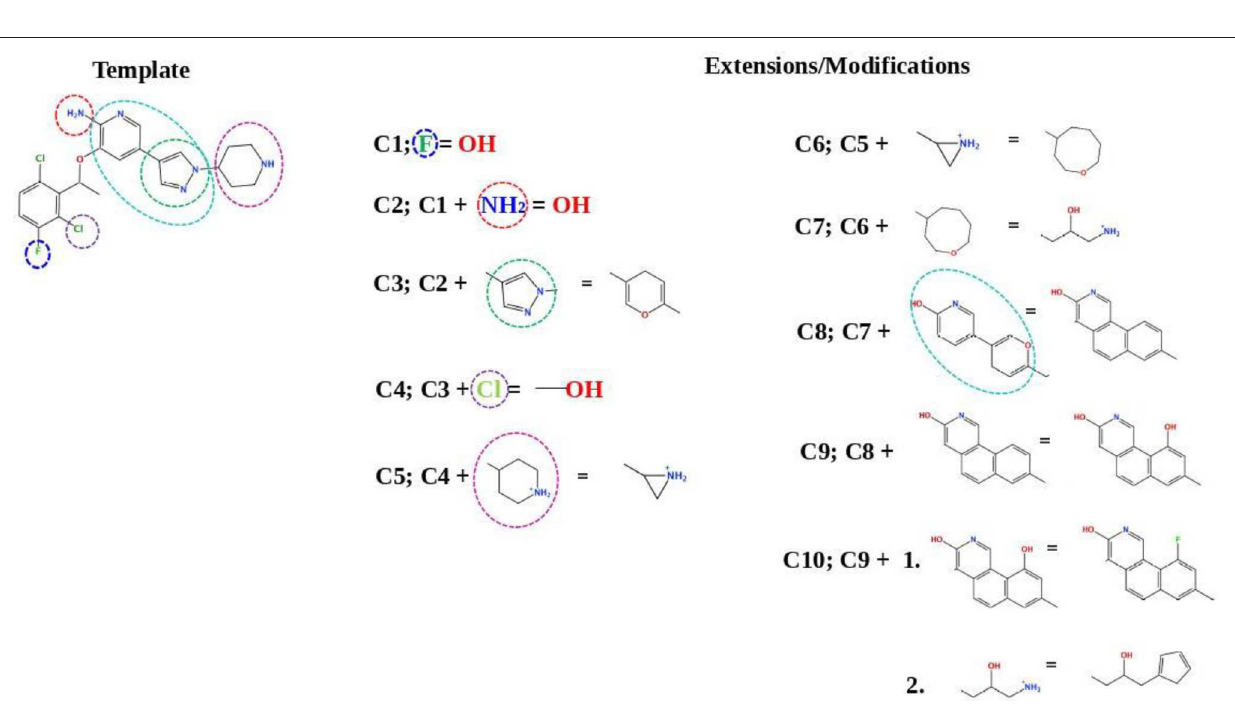
To follow this path, molecular docking and molecular dynamics simulation approaches were devised and implemented to compare the binding affinities of known Axl